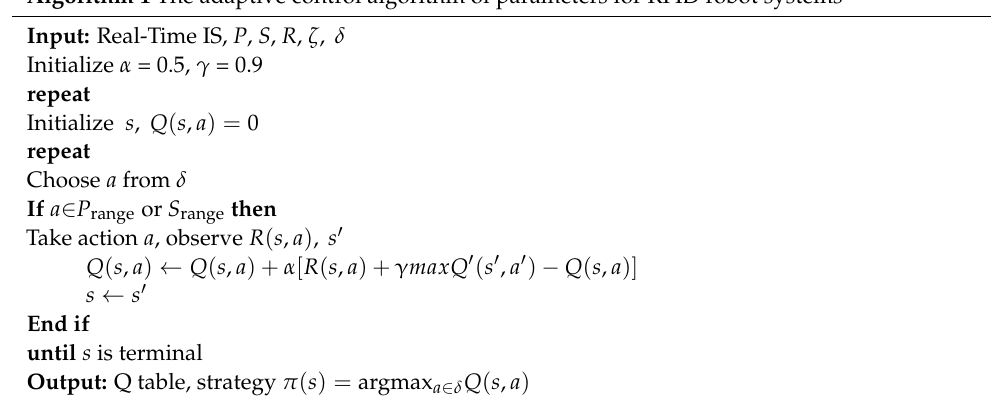
Algorithm 1 The adaptive control algorithm of parameters for RFID robot